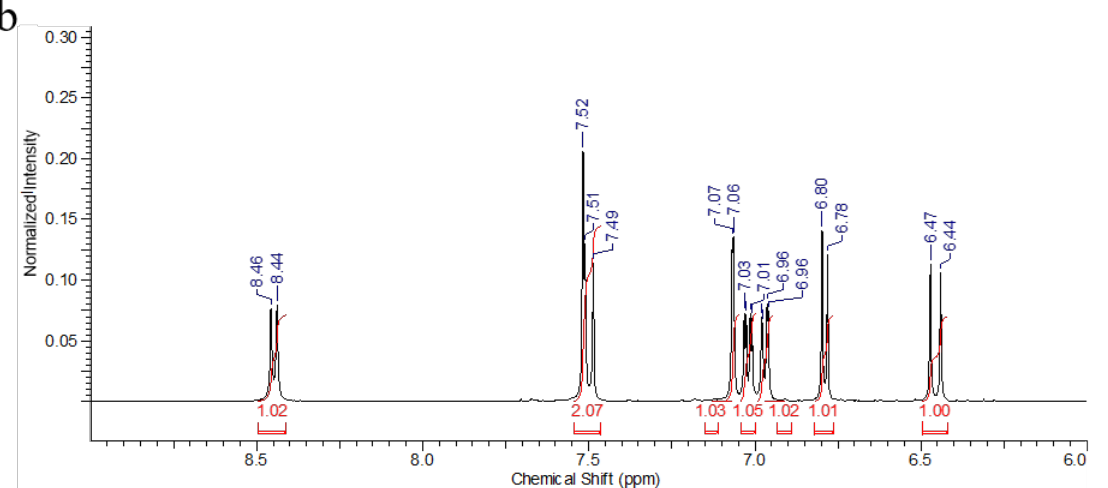
Figure 3. 1 H NMR spectra of Avn-C (MeOH-d4). ( a ) The whole spectrum. ( b ) The magnified spectrum from 9.0 to 6.0 ppm.